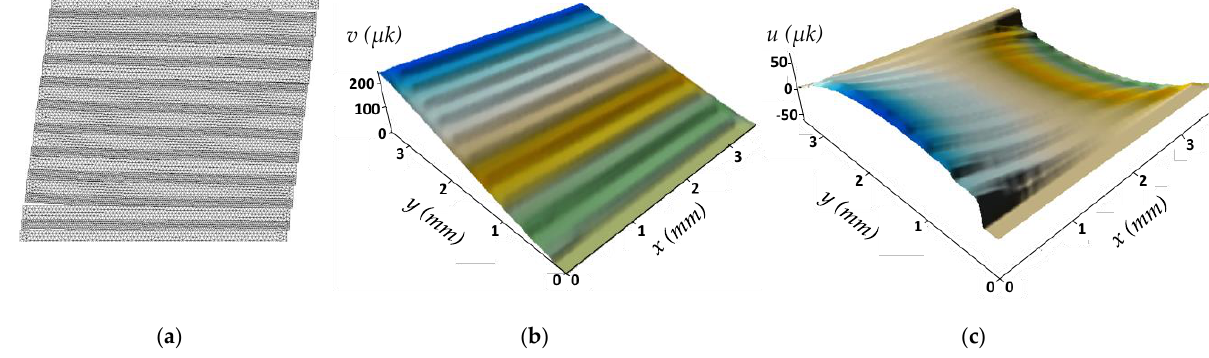
Figure 17. The computational domain of shear along CF for the CF/PEEK ratio of 60/40 vol. %: ( a )—the FEM mesh; ( b , c )—surfaces of displacement along the y and x axes, respectively.